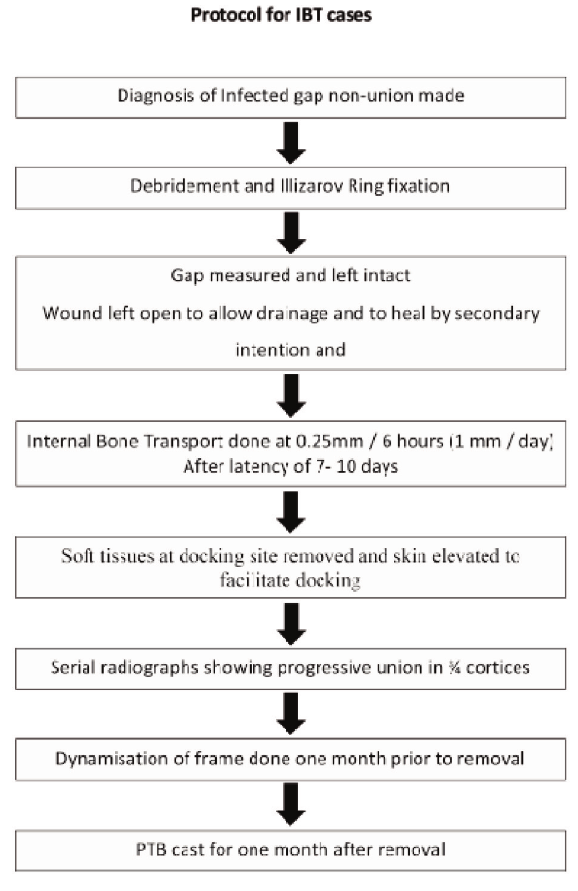
Protocol for Internal Bone Fig. 8: